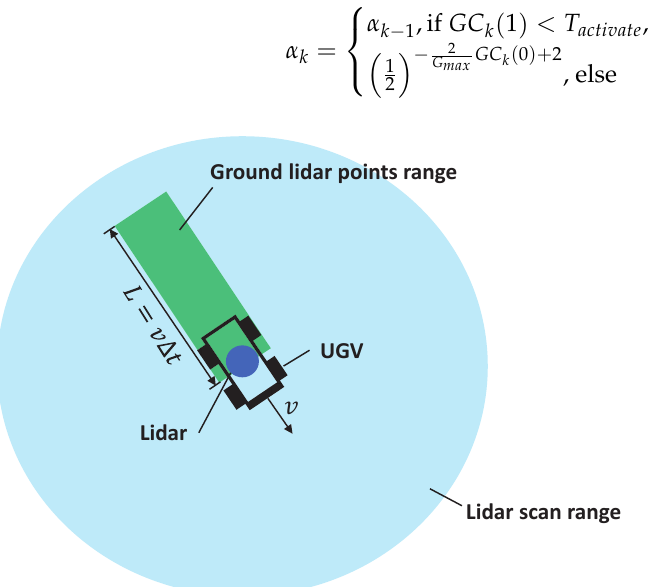
Figure 2. The range of the ground lidar points. v is the current velocity from the state vector evaluated by ESKF, ∆ t is the time period utilized to compute the distribution of IMU measurements and the width of the ground region is the width of the